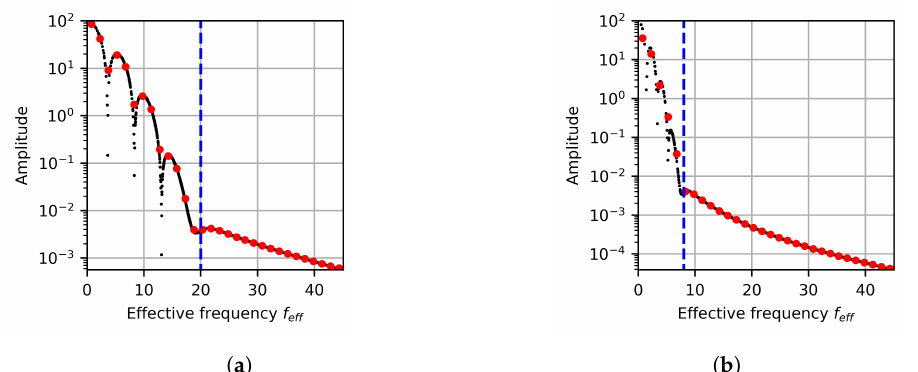
Figure 7. A 1D projection of the FFT data for the single circle image with ( a ) r 0 = 0.1 and ( b ) r 0 = 0.25. The dashed blue line indicates the HFLS.